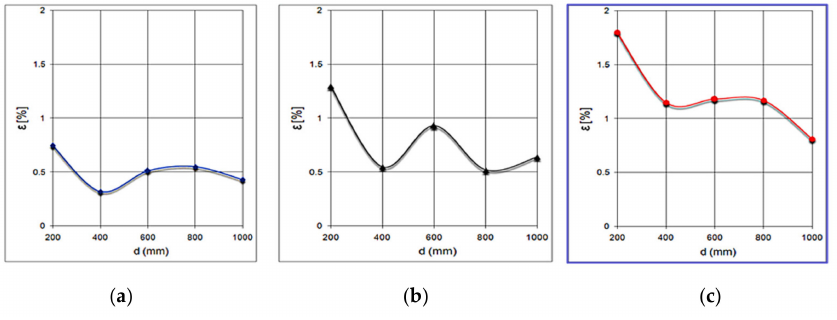
Figure 17. Variations of the relative error for obstacles of different sizes. Error of detection for objects 60 mm wide ( a ), 40mm wide ( b ) and 20 mm ( c ). Error increases inversely with the object width.